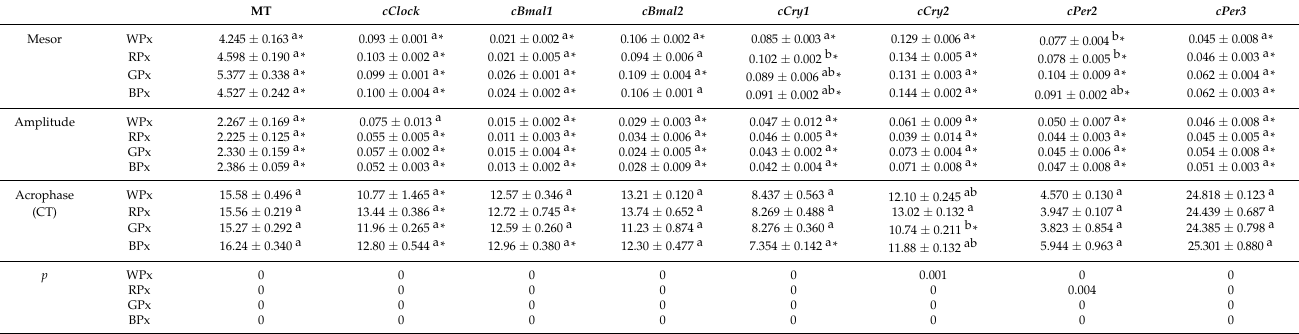
Daily temporal differences were analyzed by SPSS 20 with one-way ANOVA. Rhythm parameters (mesor, ampli- tude, acrophase) were generated by Originlab Software 9.3, and were shown as the Mean ± SEM. MT: melatonin; Different letters indicate significant differences among the monochromatic light groups and “*” indicate significant differences between pinealectomy group and control